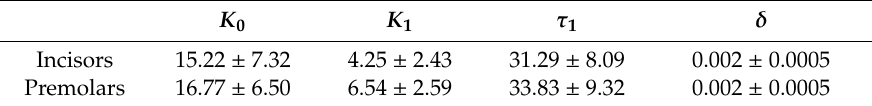
Table 2. Fitting parameters of the one-exponential function for temperature growth during polishing with water cooling, showing the average for all tested samples (n = 32).